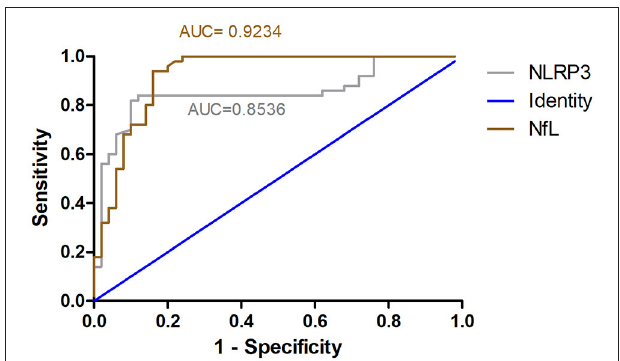
FIGURE 5 | ROC curve for NLRP3 and NfL predicts alcohol dependence. ROC curve analysis was used to evaluate the predictive value of NLRP3 and NfL for the diagnosis of alcohol dependence. The areas under the ROC curve were 0.8536 for NLRP3 levels and 0.9234 for NfL